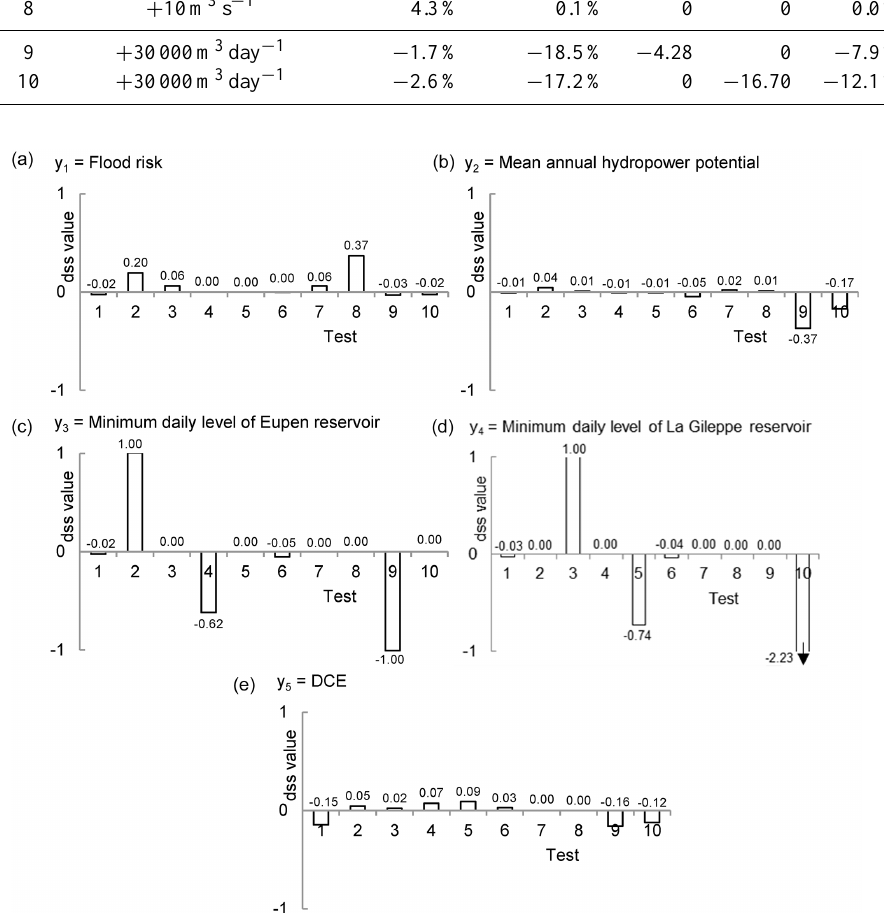
Figure 4. Local sensitivity analyses of the operation rules parameters.